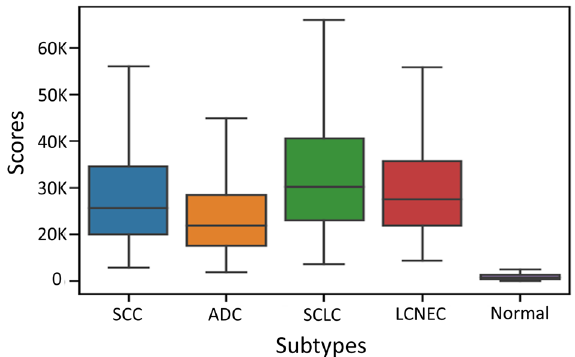
Figure 9. HipoMap distributions on the subtypes.